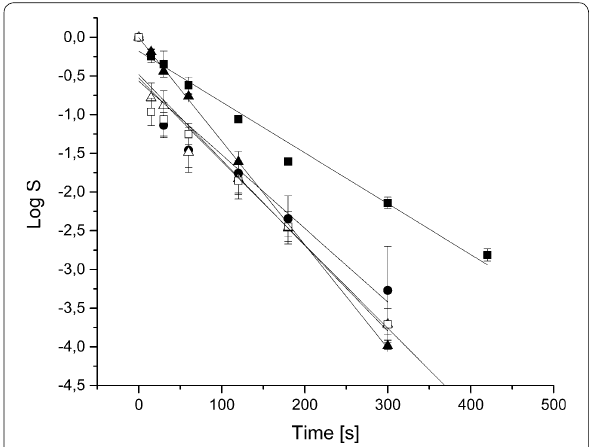
Fig. 5 Resistance against liquid H 2 O 2 , shown as D H2O2 -value in sec- onds, as a function of the water contact angle with linear